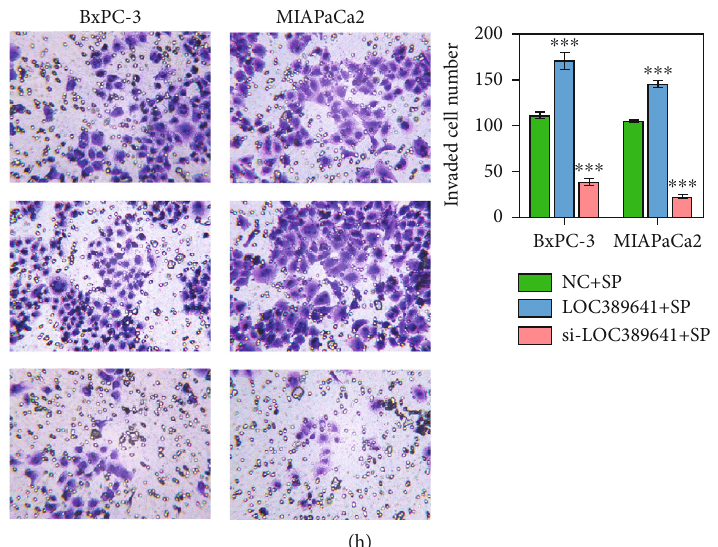
Figure 6: Overexpression of LOC389641 promoted the proliferation, migration, and invasion of pancreatic cancer cells. (a) The levels of LOC389641 and TNFRSF10A expression in the NC +SP, LOC389641+ SP, and si-LOC389641+SP groups were evaluated by qRT-PCR. (b, c) Protein expression was assessed by western blotting and IF. (d, e) Cell proliferation rates for the NC+ SP, LOC389641+SP, and si- LOC389641+SP groups were analyzed by CCK-8 and EdU staining assays. (f, g) Transwell and wound-healing assays were performed to evaluate cell migration ability. (h) Cell invasion was assessed by the Transwell assay. ∗ P < 0 : 05 , ∗∗∗ P < 0 : 001 vs. NC +SP group.